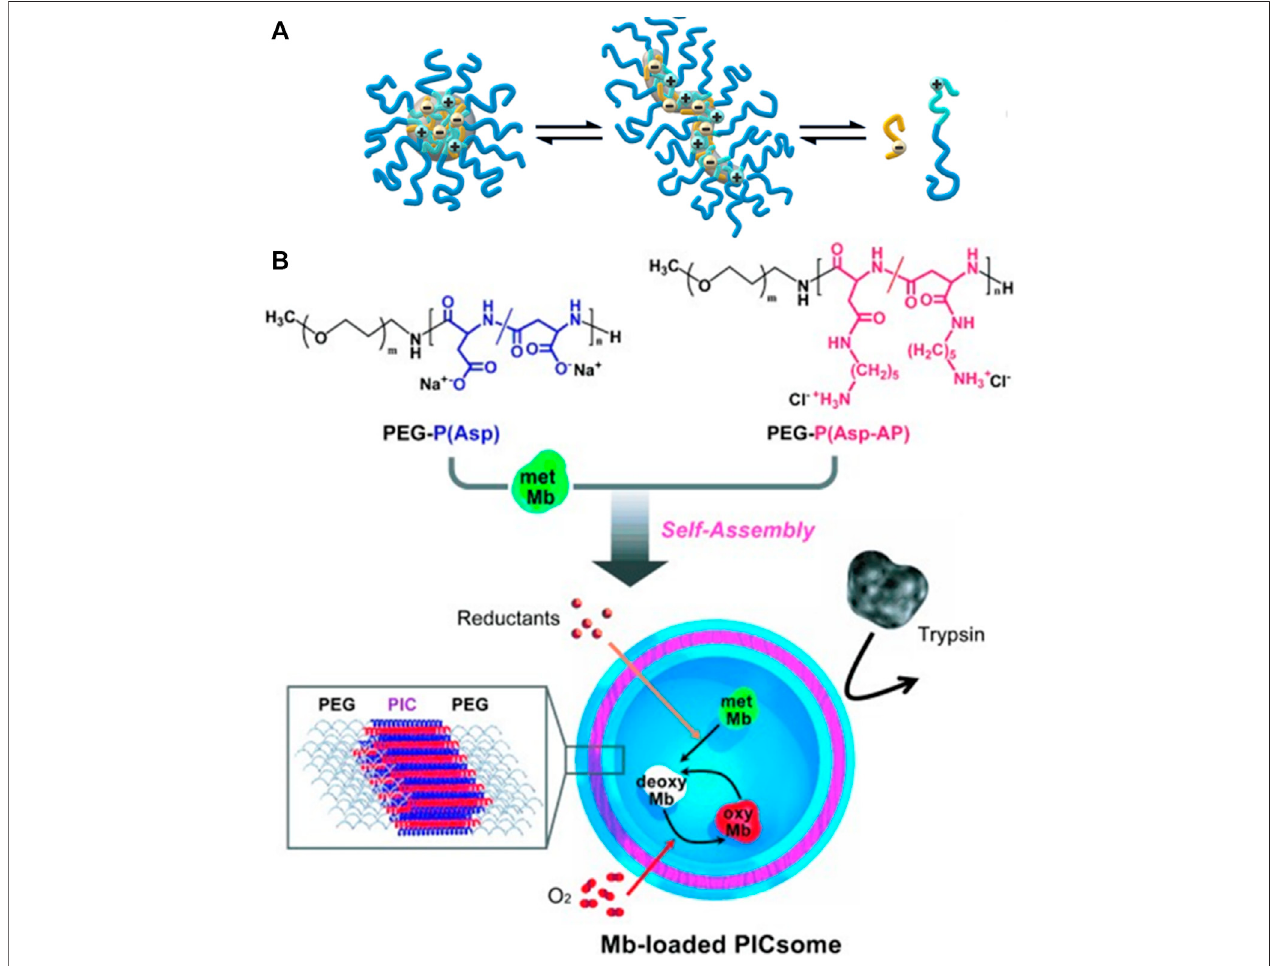
FIGURE 3 | Electrostatic self-assembly with double-hydrophilic block-polyelectrolytes: (A) Formation of spherical complex coacervate core micelles from anionic poly (acrylicacid)(red) and blockcopolymerconsisting ofacationic poly (N-methyl-2-vinylpyridinium) (blue)and aneutralpoly (ethylene oxide) block (green); An increase inthesaltconcentrationleadstotheformationofanelongatedworm-likestructure;anevenfurtherincreaseinthesaltconcentrationabovethecriticalsaltconcentration leads to the separation of the polymers (van der Kooij et al., 2012); (B) Reversible myoglobin (Mb) oxygenation inside the polyion complex membrane self- assembledfromapairofoppositelychargedblockpolyelectrolytes(Kishimuraetal.,2007).Reprintedwithpermission.Copyright © 2007WILEY-VCHVerlagGmbHand Co. KGaA,